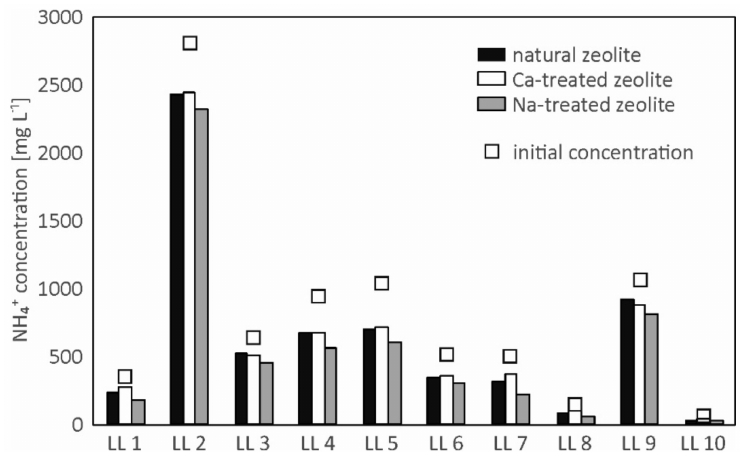
Figure 4. Initial ammonium concentrations (squares) and remaining concentrations after treatment with di ff erently treated zeolites (bars) in di ff erent landfill leachates (LL).